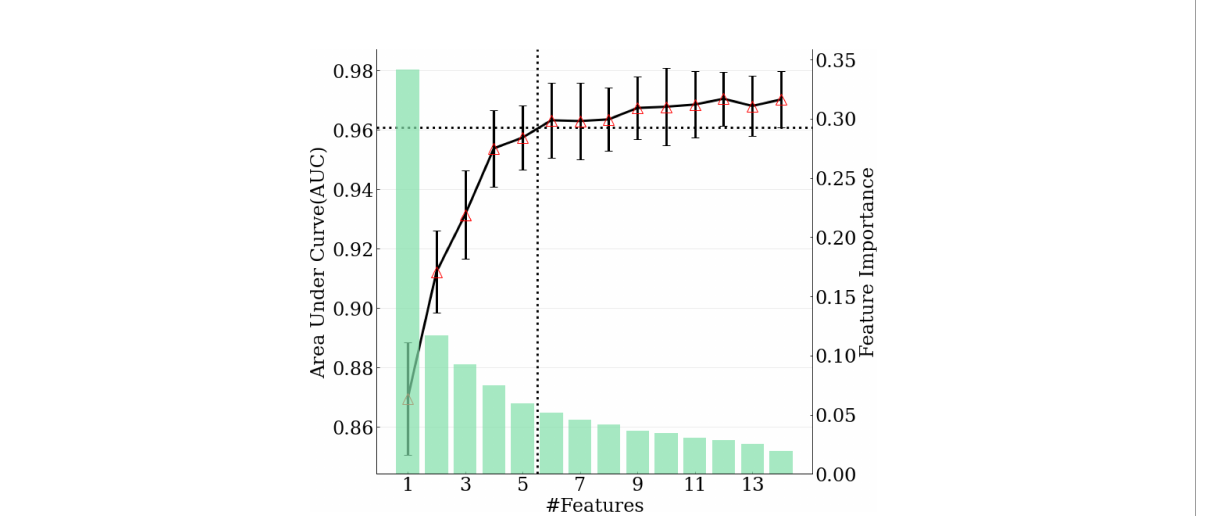
FIGURE 3 Relation between number of features selected in the model and model performance. Green bars correspond to feature importance. Black solid line corresponds to AUC calculated with top 1-14 features. Black dotted lines demonstrate the number of features selected when achieving 99% of maximum AUC.